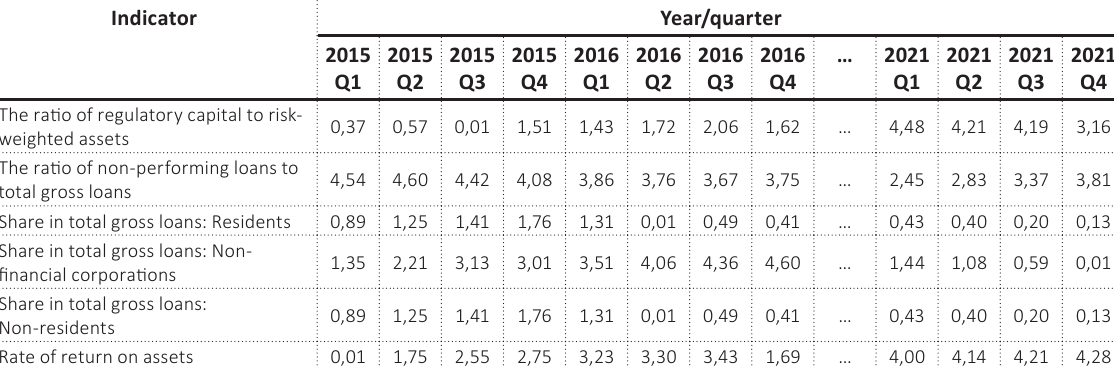
Table А2. Normalized values of indicators for characteristics of the financial sector security in Ukraine